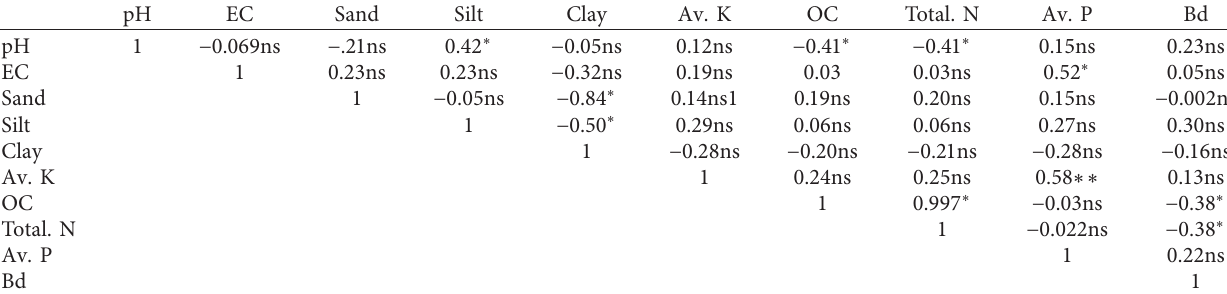
Table 5: Correlation between observed soil physicochemical